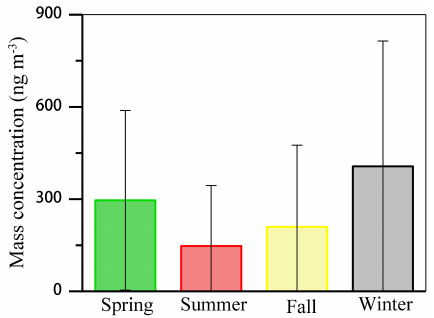
Figure 7. Seasonal variation of elemental concentrations con- tributed by coal combustion in Shanghai. The error bar indicates one standard